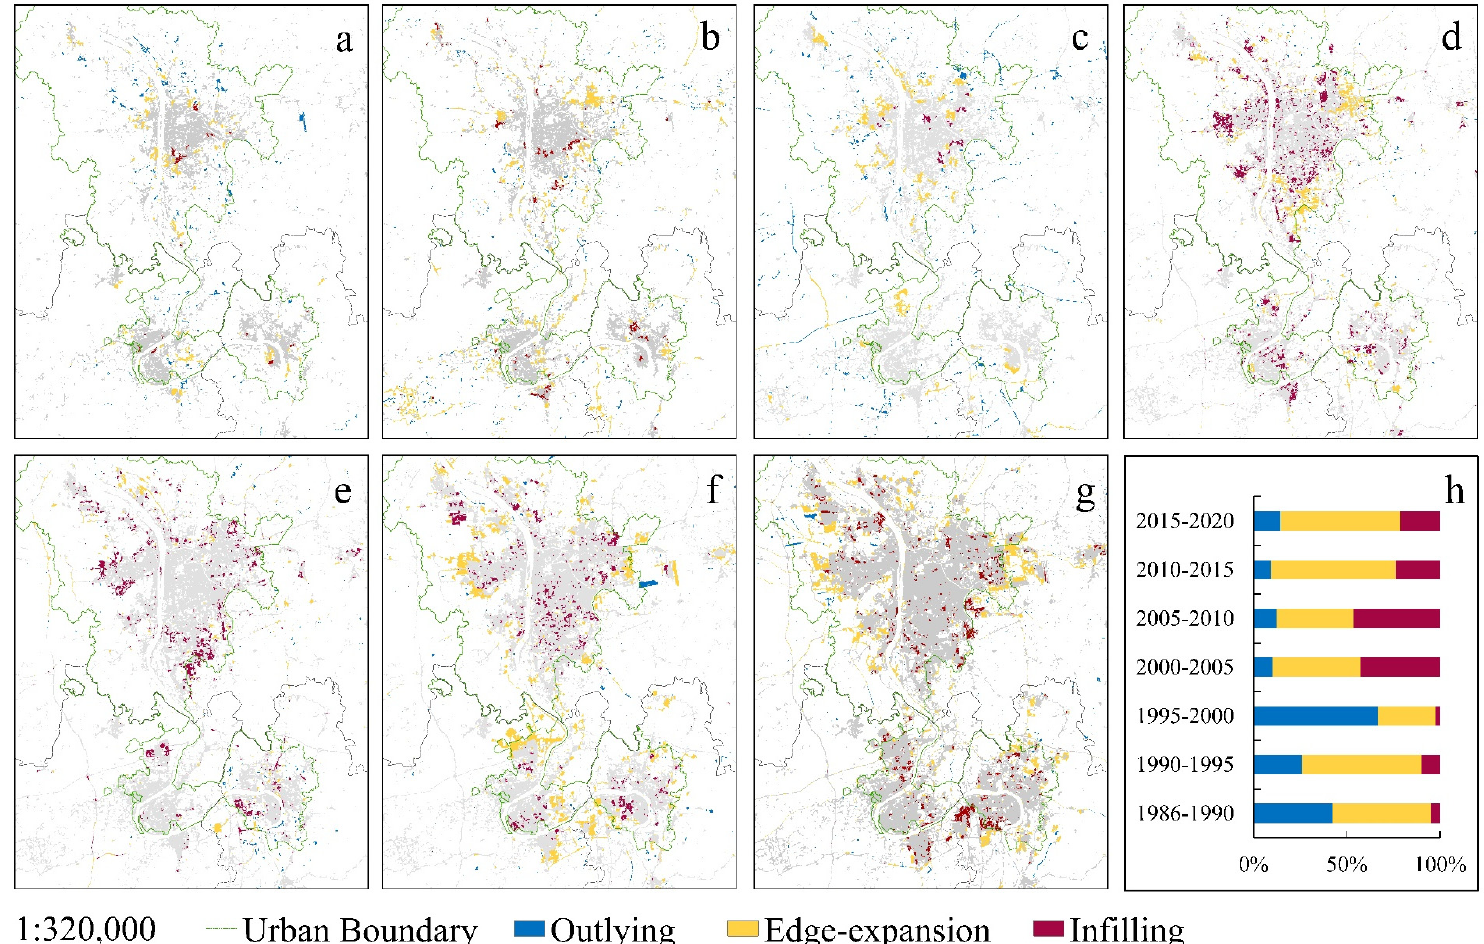
Figure 5. The expansion morphology in the CZT urban megaregion in 1986–2020: ( a – g ) the subsets for the spatial patterns of expansion morphology in the developed land clusters of Changsha, Zhuzhou, and Xiangtan, where the corresponding five-year intervals were 1986–1990, 1990–1995, 1995–2000, 2000–2005, 2005–2010, 2010–2015, and 2015–2020; ( h ) the area percentage of the three expansion types.